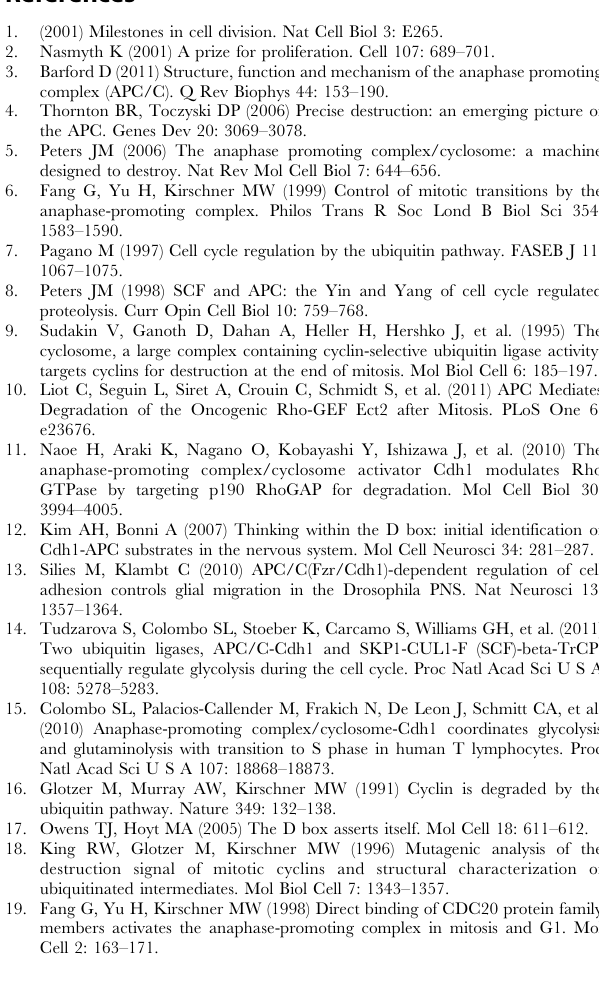
Table S3 The top 15 most enriched biological processes, molecular functions and cellular components of the KEN-box proteins in H. sapiens . Table S4 The top 15 most enriched biological processes, molecular functions and cellular components of newly predicted D-box proteins in H. sapiens . The proteins in the training data set were excluded. Table S5 The top 15 most enriched biological processes, molecular functions and cellular components of newly predicted KEN-box proteins in H. sapiens . The proteins in the training data set were excluded. Table S6 Statistical comparison of the GO terms for the substrates between the predicted KEN-box and D-box proteins in the human proteome. Yates’ Chi-square ( x 2 ) test was performed ( p - value , 0.05) [32]. The entries with the grey background indicate the Enrichment_ratio # 1.